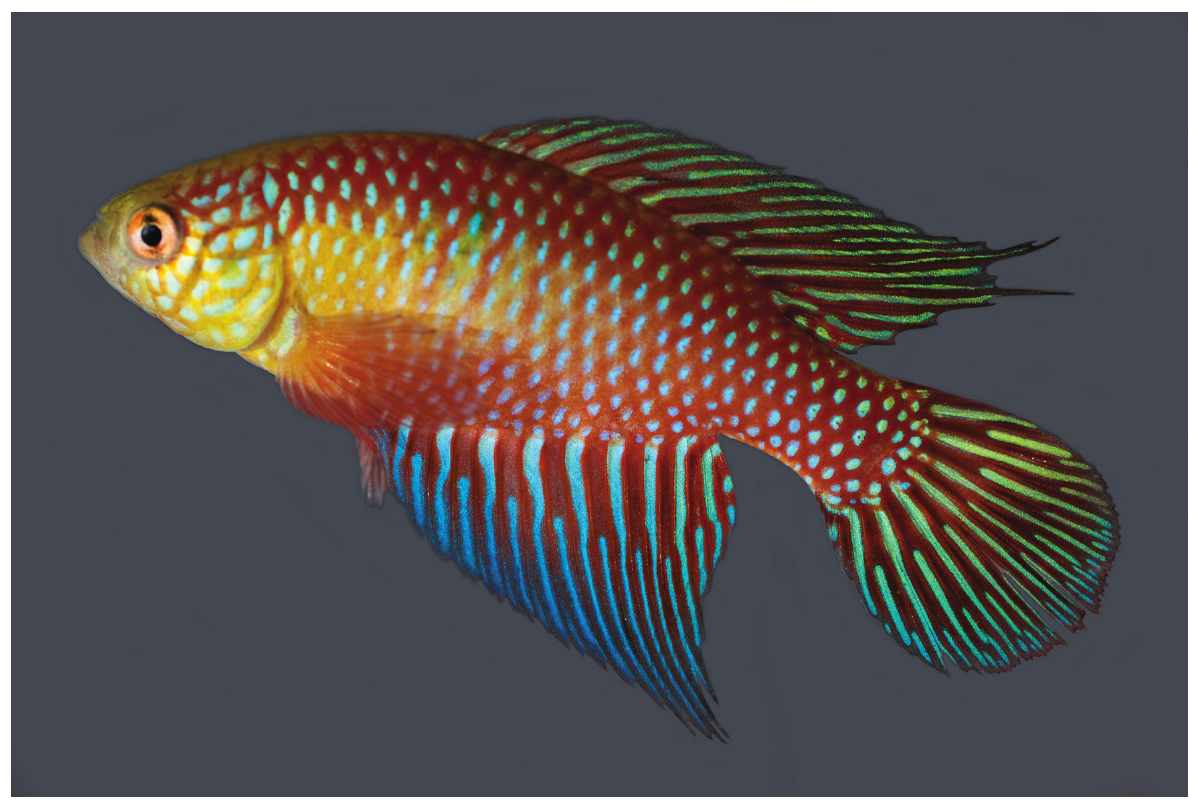
Figure 2. Hypsolebias splendissimus Costa sp. n., live holotype, UFRJ 6909, male, 42.7 mm SL. Photograph by W.J.E.M.